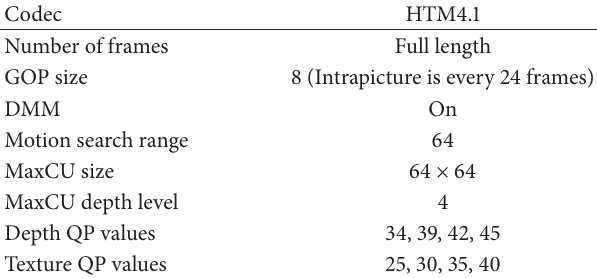
Table 6: Encoder parameters